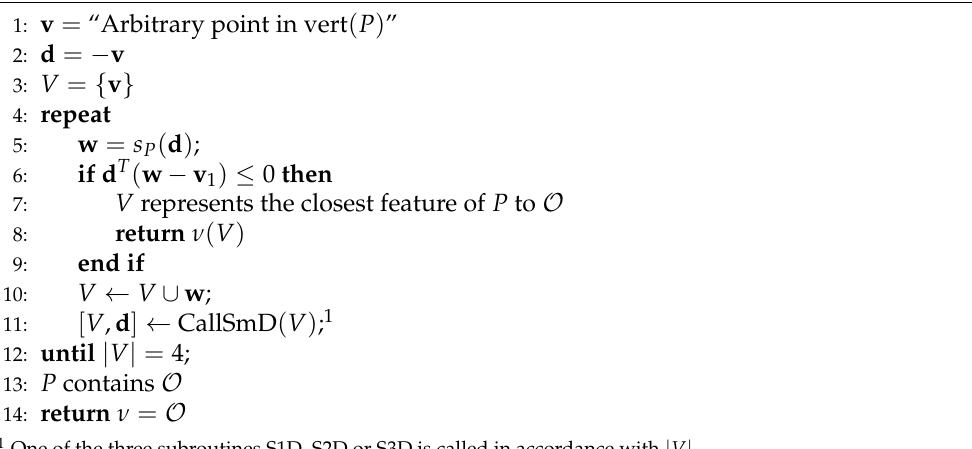
Algorithm 2 Compute the closest point of P to the origin